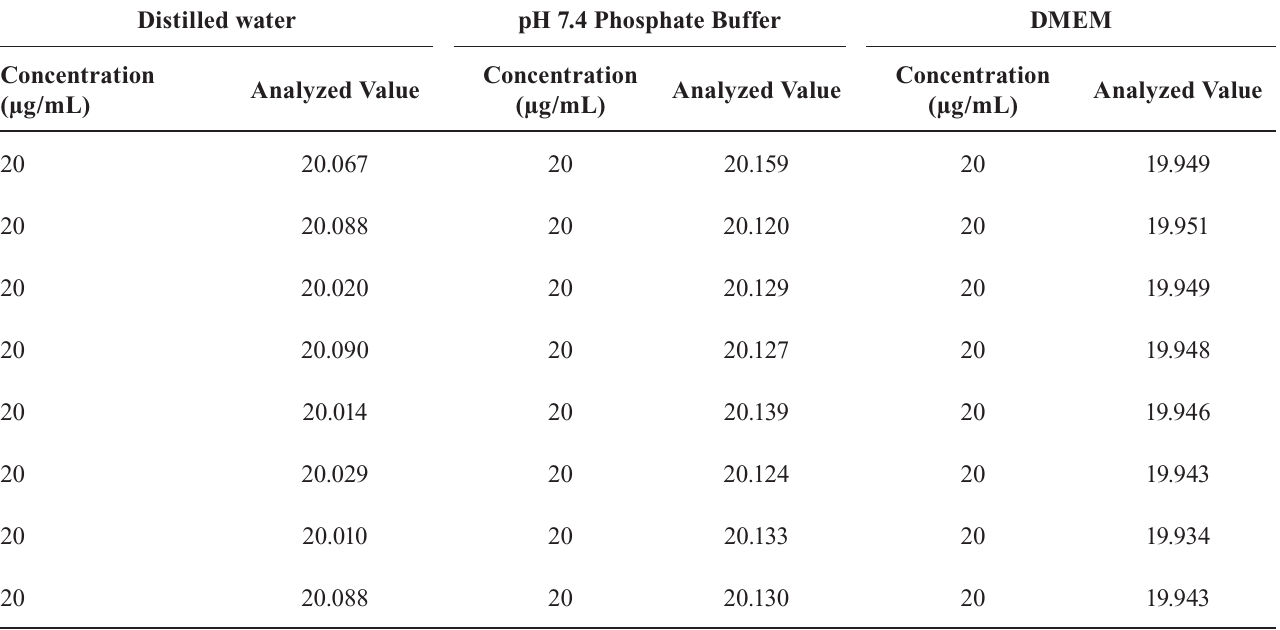
TABLE III - Intra-day precision for imatinib